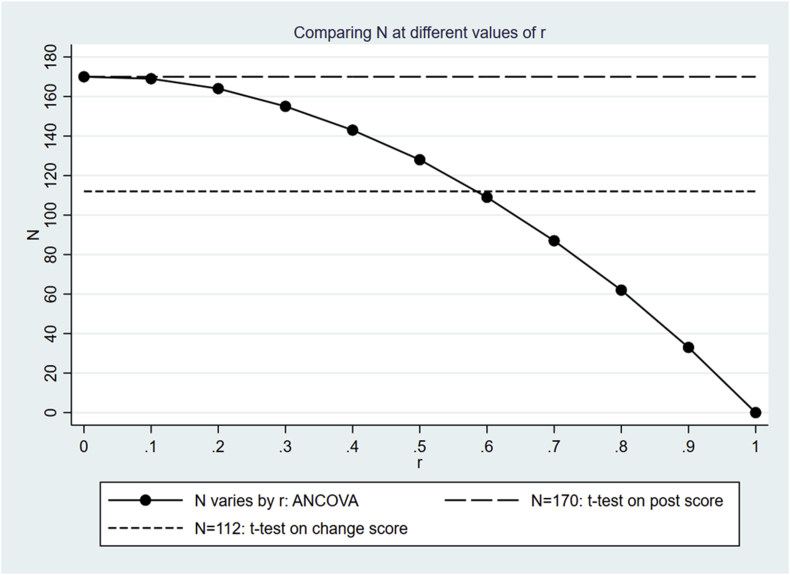
Comparing values of sample size N produced using different methods at different values of r, using the same parameter values as are shown in Table 3. The values of s(Y1−Y0)2 remain fixed for all values of r, resulting in a constant value of N=112 via a t-test for outcome (Y1−Y0), shown by the short-dashed line. Fig. 1 is intended to be compared with Fig. 2, where the values of s(Y1−Y0)2 are allowed to vary according to the values of r.